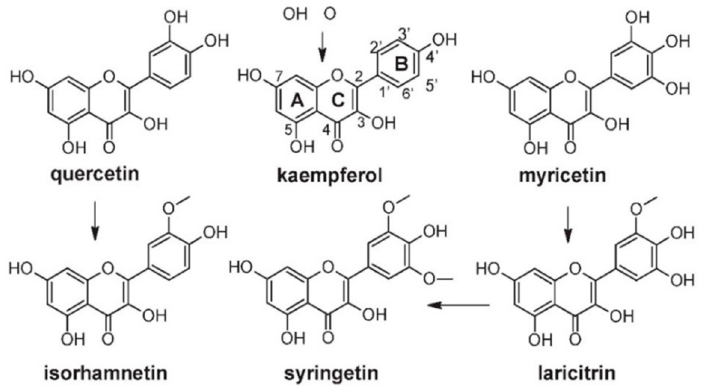
Figure 5. Structures of flavonol aglycones found in grapes [11].